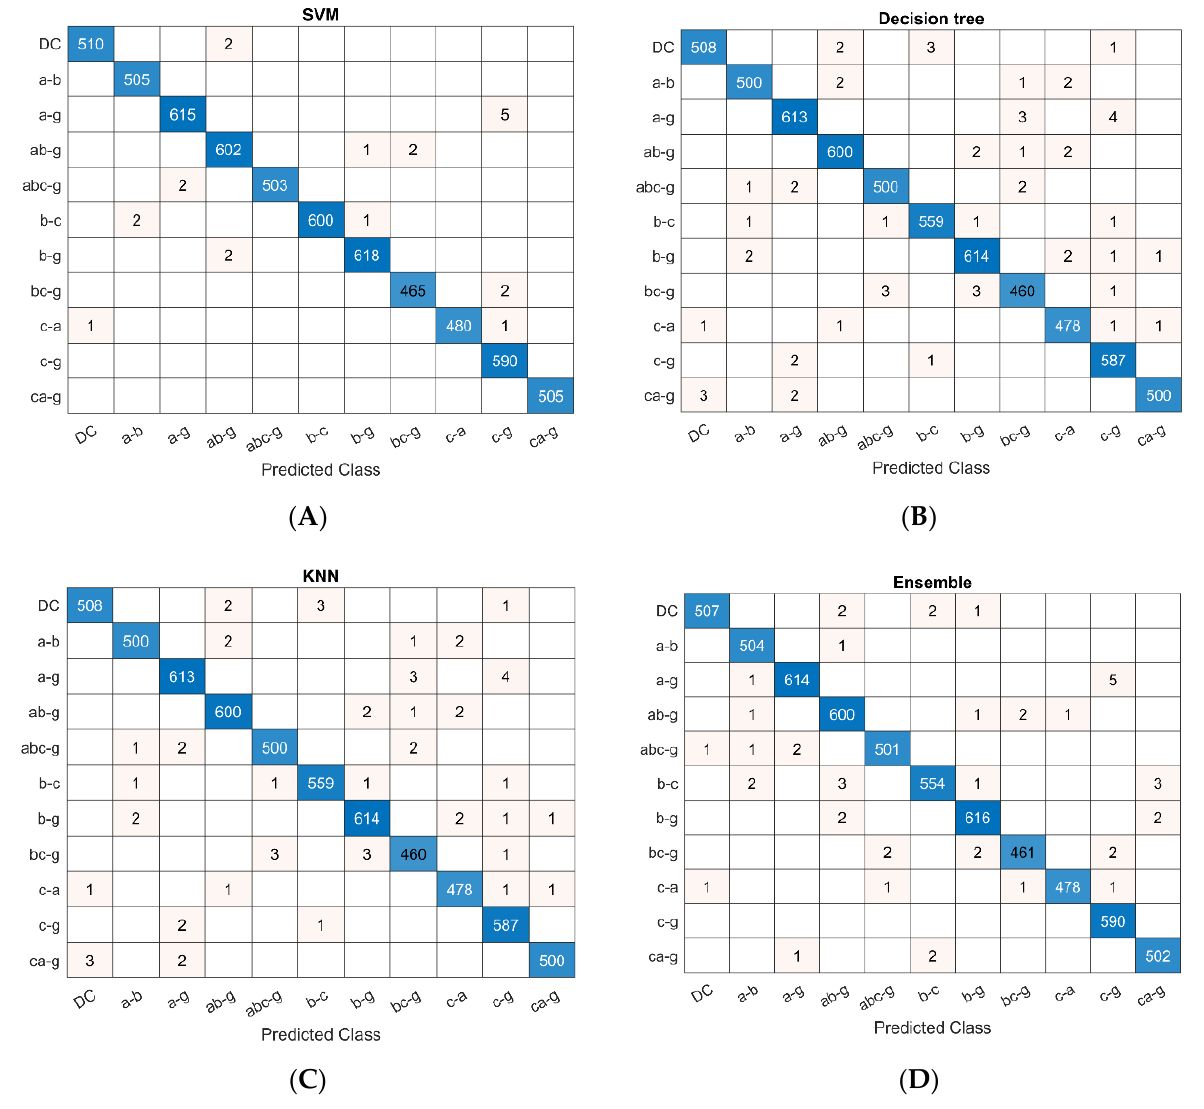
Figure 6. Confusion matrix for different classifiers ( A ) SVM, ( B ) Decision Tree, ( C ) K-NN, and ( D ) Ensemble.